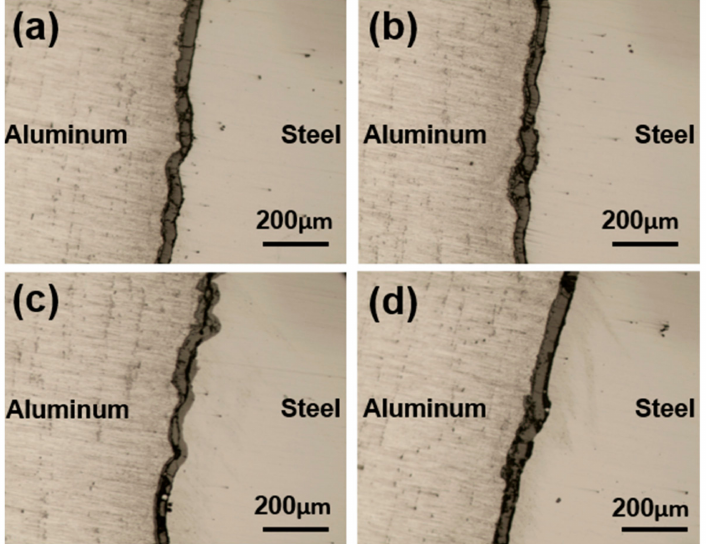
Figure 12. Interface micrographs of the bimetal gear with deformation degree of 50%: ( a ) position 1 (cid:13) ,